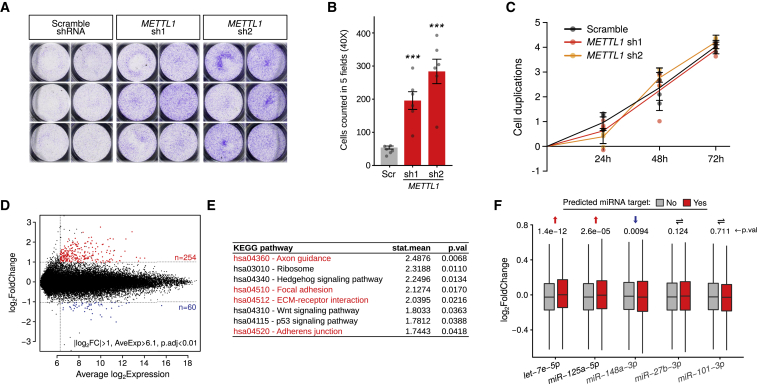
METTL1 Inhibits Cellular Migration of A549 Cells(A) A migration assay was performed for 7 h using cells infected with METTL1-specific (sh1, sh2) or control (Scramble) TET-inducible shRNAs 5 days after doxycycline treatment.(B) Results from (A) were quantitated and plotted, as indicated. The plot shows the average of six biological replicates ± SDs (∗∗∗p < 0.001, two-tailed t test).(C) A proliferation assay was initiated 4 days after doxycycline treatment of cells infected with METTL1-specific (sh1, sh2) or control (Scramble) TET-inducible shRNAs. The average of four biological replicates ± SDs is shown.(D) Global gene expression analysis of cells infected with METTL1-specific (sh1) or control (Scramble) TET-inducible shRNAs 5 days after doxycycline treatment. log2 fold change was plotted against average log2 expression. Significantly upregulated (red) and significantly downregulated (blue) transcripts are indicated. See also Figure S3.(E) Gene Ontology analysis of gene expression changes following METTL1 knockdown identifying upregulated Kyoto Encyclopedia of Genes and Genomes (KEGG) pathways involved in cellular migration (red).(F) log2 fold change in the expression of predicted targets of the indicated miRNAs upon METTL1 knockdown. Each pair of boxplots compares the fold change of mRNAs that are targets (red) or not (gray) of a single specific miRNA. Statistical significance was calculated by the Wilcoxon test.